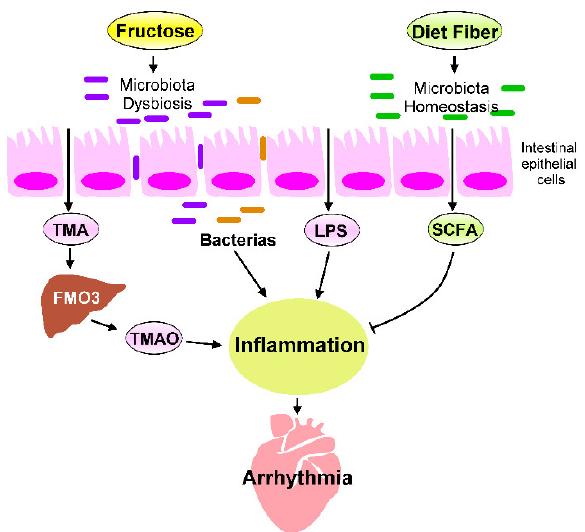
Figure 3. Fructose-mediated heart–gut axis disorder that promotes inflammation and cardiac arrhythmogenesis. Dietary components, such as fructose or dietary fiber, serve as crucial environmental factors that influence the homeostasis of gut microbiota and alter gut microbiota-derived metabolites. Excessive fructose intake promotes microbiota dysbiosis, which increases the production of trimethylamine (TMA), which is then converted into trimethylamine-N-oxide (TMAO) by the flavin-containing monooxygenase 3 (FMO3) expressed in the liver. SCFAs are generated through the fermentation of dietary fibers by gut microbiota. SCFAs are crucial players in regulating the beneficial effect of dietary fibers. The microbiota endotoxin and metabolites, such as lipopolysaccharide (LPS), TMAO, and SCFAs, mechanistically regulate the chronic inflammation that affects cardiac rhythm. Targeting inflammation caused by imbalanced intestinal flora may prevent cardiac arrhythmogenesis.